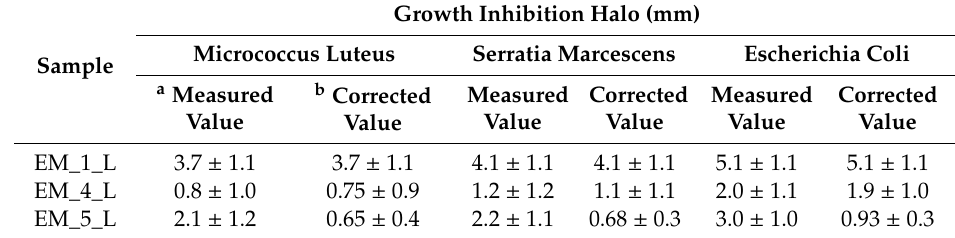
Table 3. Antimicrobial activity conducted as growth inhibition halos (average value ± standard deviation, n = 3).